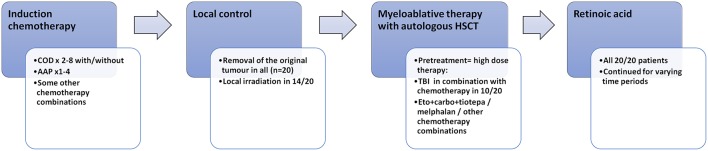
Oncologic treatment in the 20 long-term survivors of high-risk neuroblastoma. COD, cyclophosphamide + vincristine + DTIC; AAP, ciplatin + doxorubicin; HSCT, hematologic stem cell transplantation; TBI, total-body irradiation.